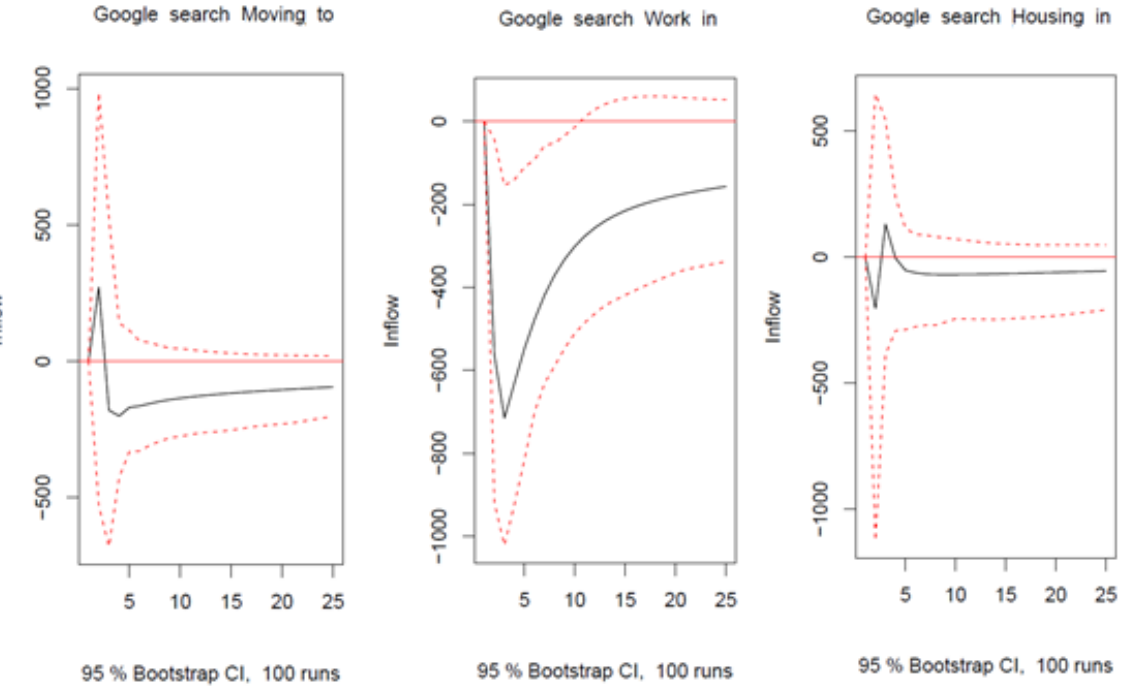
Figure 3. VAR (1) with centered seasonal dummies: orthogonalized impulse responses from a shock in Google searches on migration inflow in Moscow over 24 months.